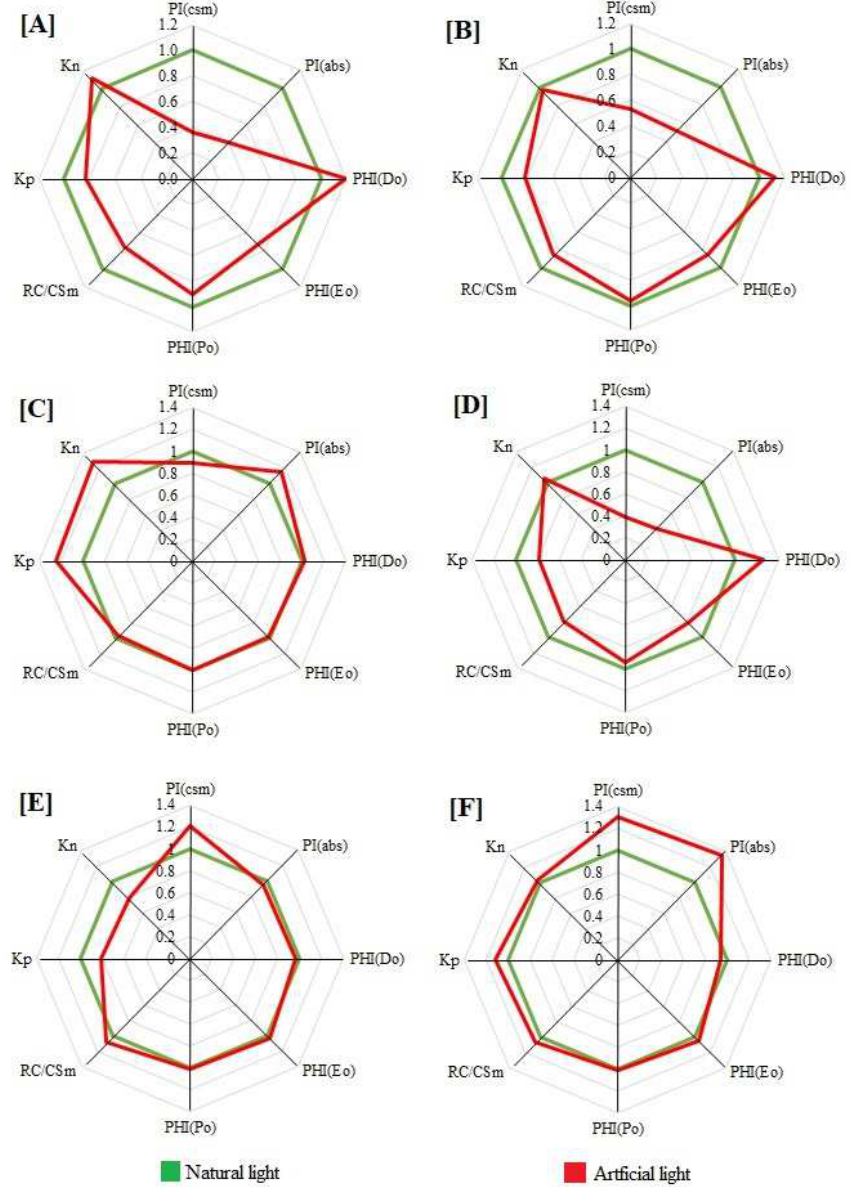
Figure 2. A radar plot of selected JIP parameters derived from chlorophyll a fluorescence S. asoca ( A ), T. catappa ( B ), B. variegata ( C ), H. integrifolia ( D ), F. benjamina ( E ) and T. peruviana ( F ) growing under artificial-light and natural-light conditions. Values presented are the average of three